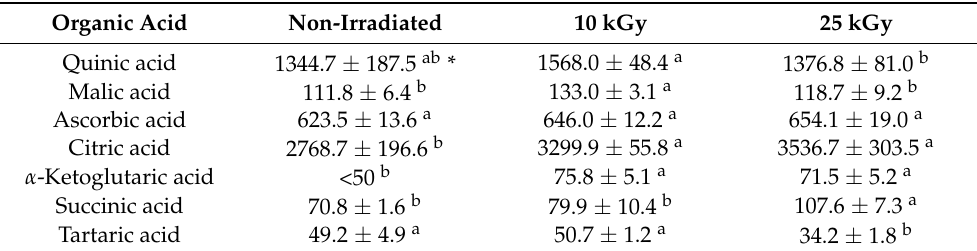
Table 1. Organic acid composition of non-irradiated, 10 kGy- and 25 kGy-irradiated RH fruits (mg/100 g dw). Organic Acid